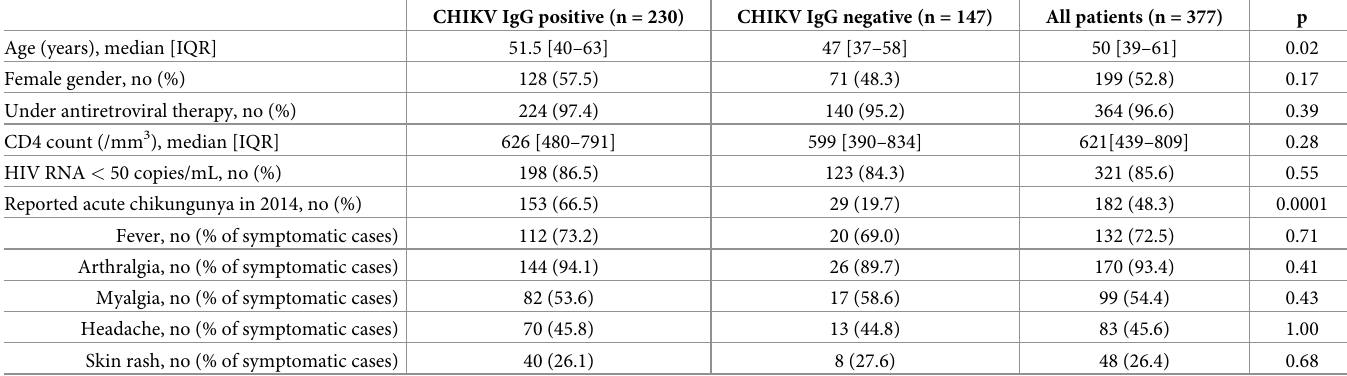
Table 1. Main characteristics of the 377 participants.